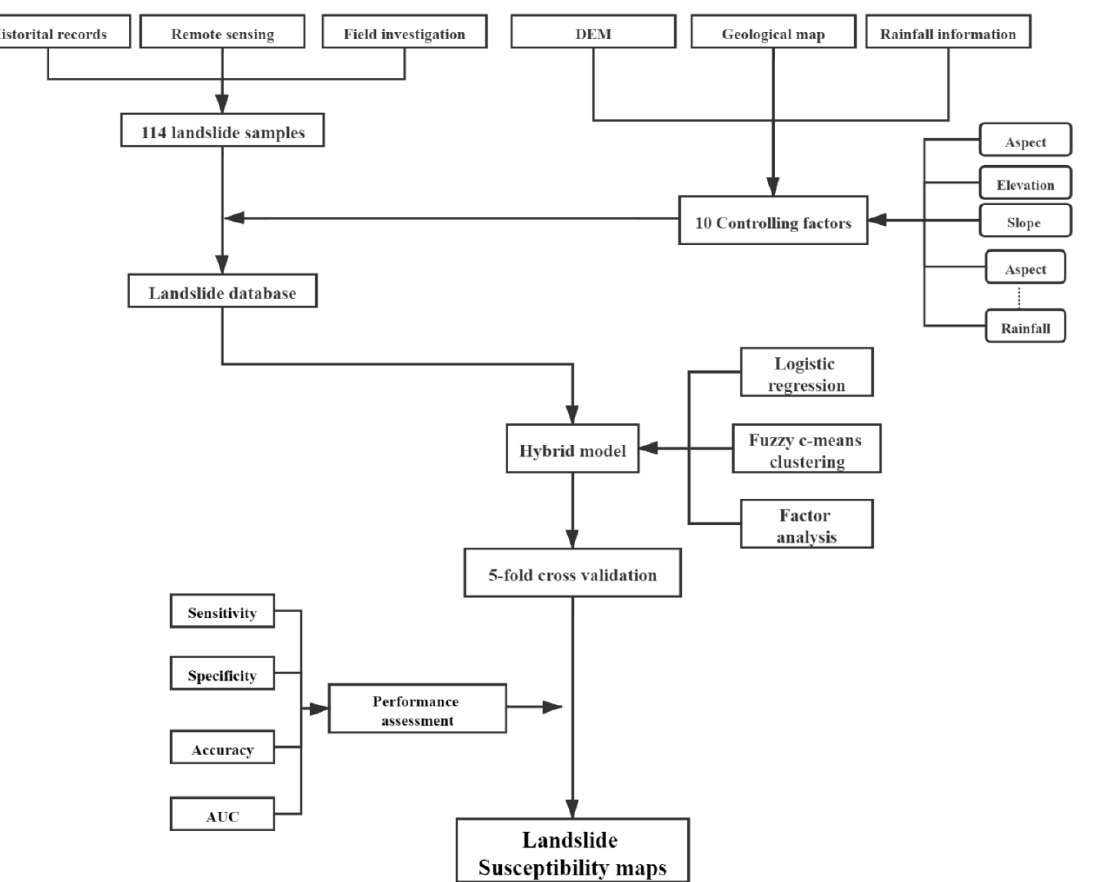
Figure 5. Flow chart of the methodology applied in the